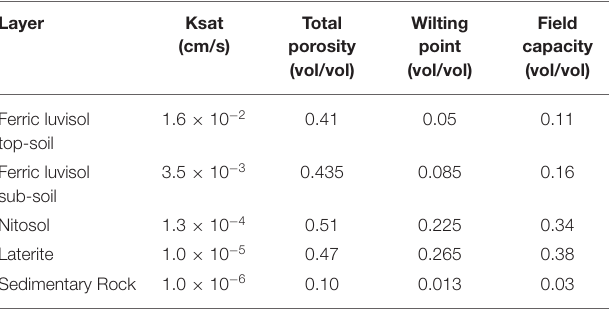
Total Wilting (cm/s) porosity point (vol/vol) (vol/vol)